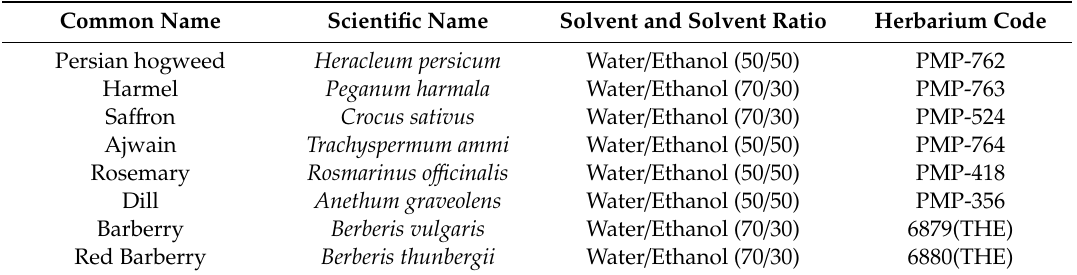
Table 1. Medicinal herbs and the solvent ratios used for the extraction process and herbarium